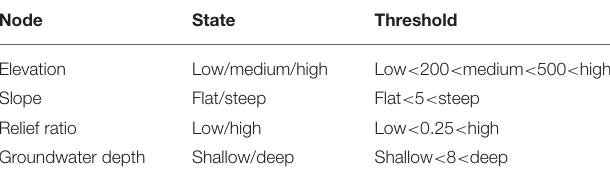
TABLE 1 | Node states and